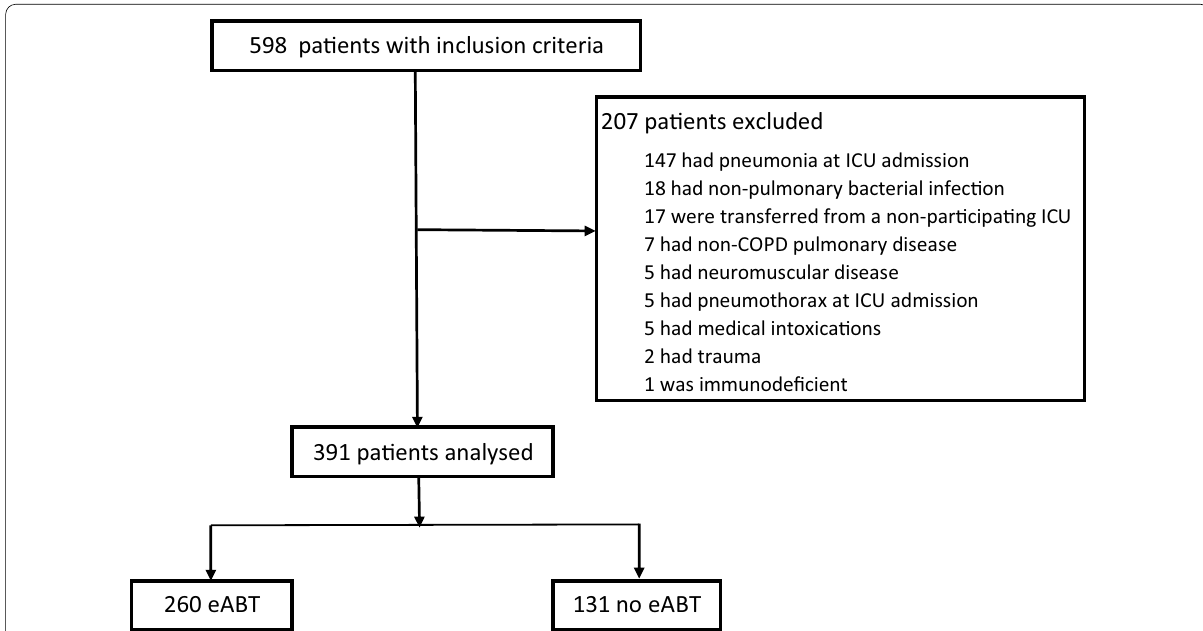
Fig. 1 Patients screening. Screening lasted from July 2012 to January 2020. eABT was defined as the first line of antibiotic therapy introduced during the first 24 h after ICU admission. eABT early antibiotic therapy, ICU intensive care